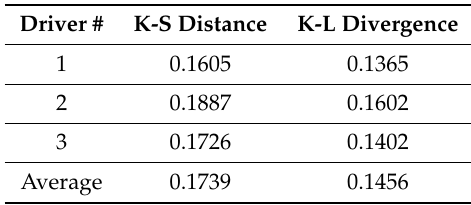
Table 4. K-S distance and K-L divergence values of the spacing gap